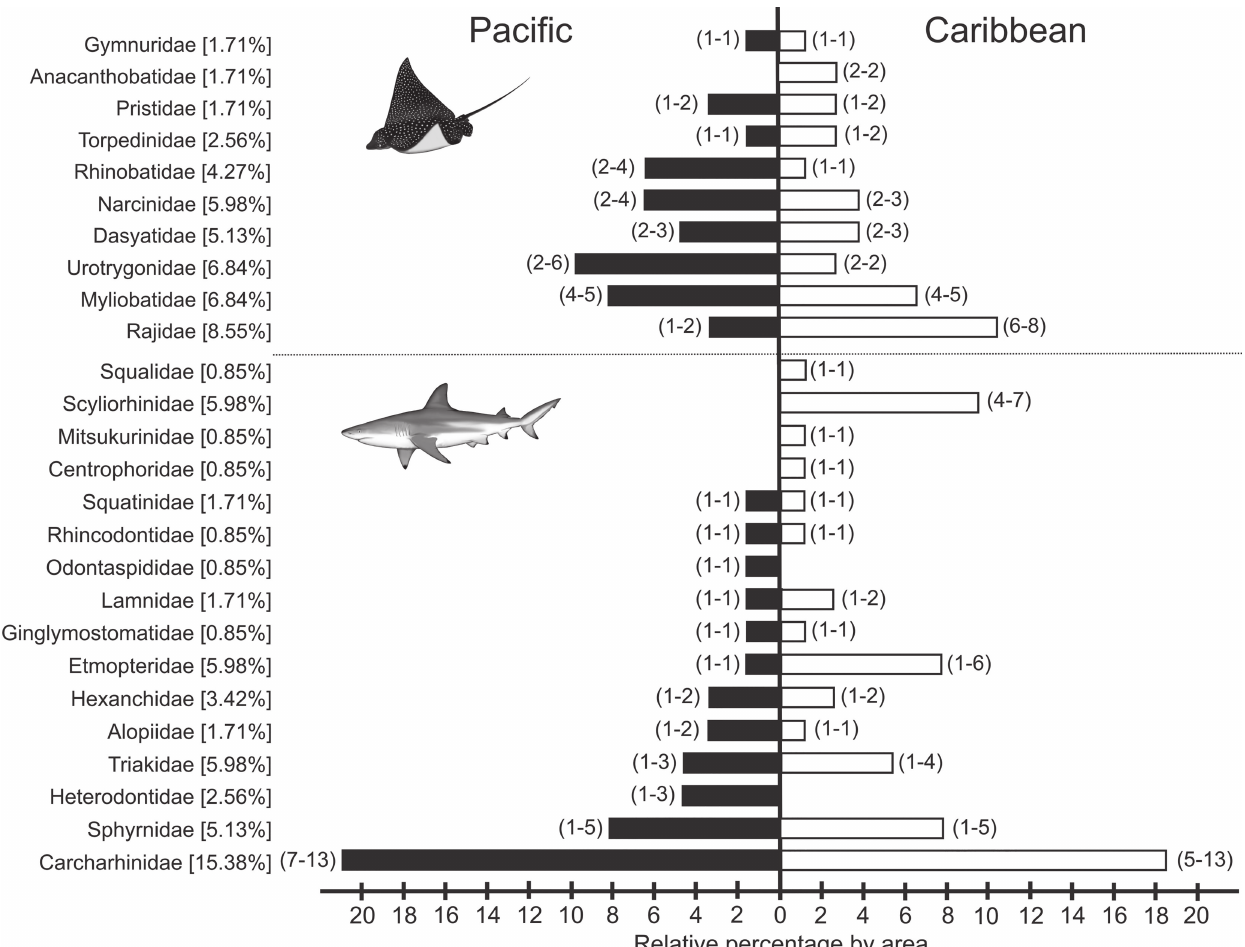
Fig. 2. Relative contribution of each family to the total richness of elasmobranchs for both areas combined (values in brackets) and by area, Colombian Pacific (black bars) and Caribbean (white bars). Values in parentheses indicate the total number of genera (first entry) and species (second entry) per